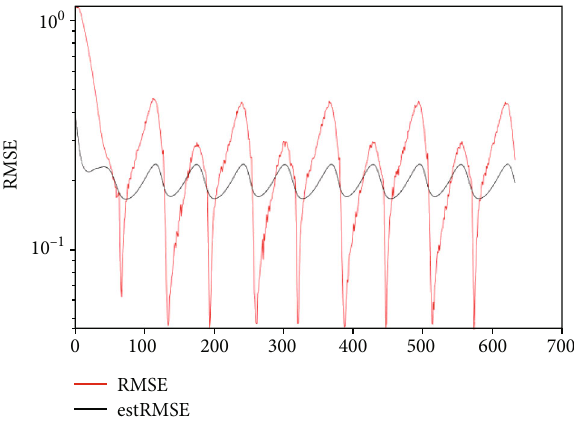
Figure 7: State estimation results after adaptive system noise correction.